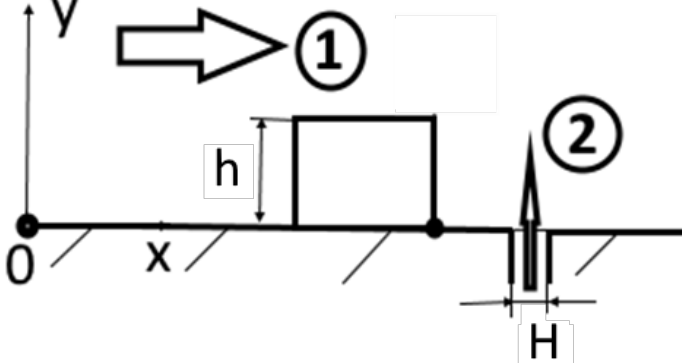
Figure 12. Scheme of two-phase flow behind a 2D square obstacle. The 1 is the single-phase air flow with the mean mass velocity U m 1 , and the 2 is the dispersed phase stream U P 1 with the mean mass velocity U